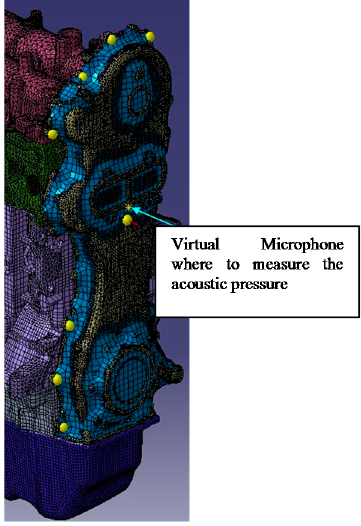
Figure 8. Vibro-acoustic model for the acoustic analysis.